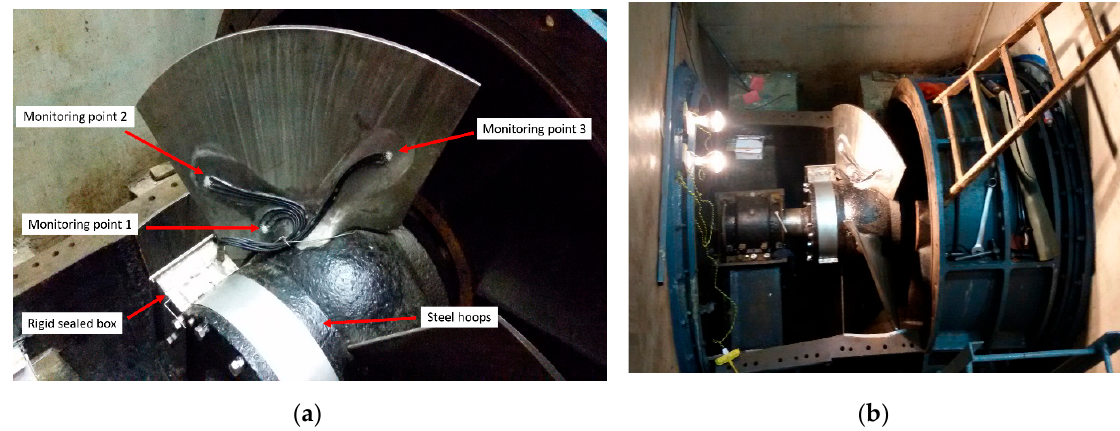
Figure 15. Monitoring the point arrangement and the on-site test instrument, ( a ) the arrangement of the on-site monitoring point, ( b ) the installation and fixation of a test instrument.